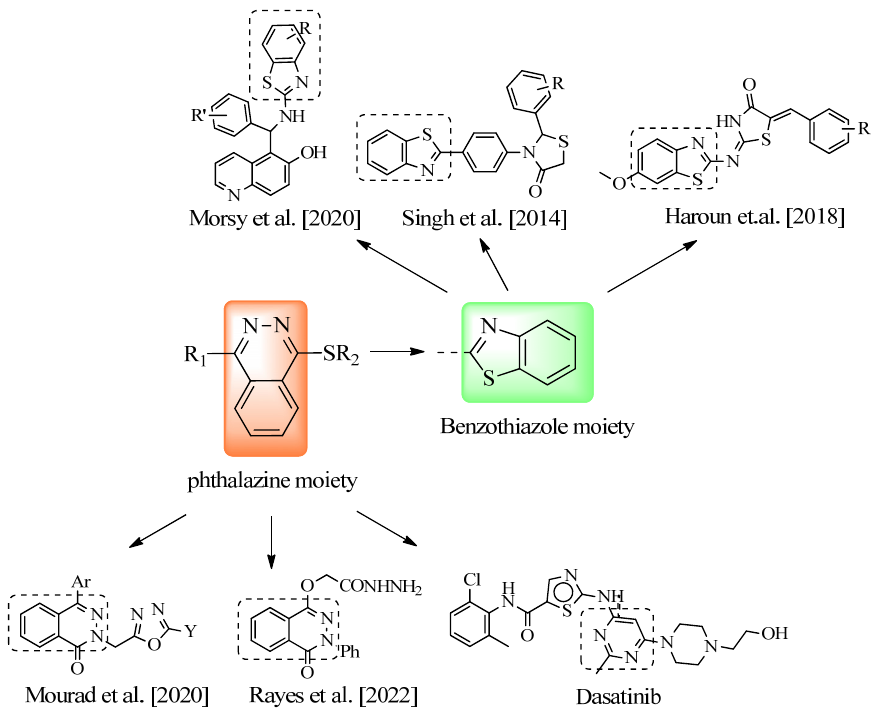
Figure 2. Compounds design based on bibliography [4,5,22,25,26].